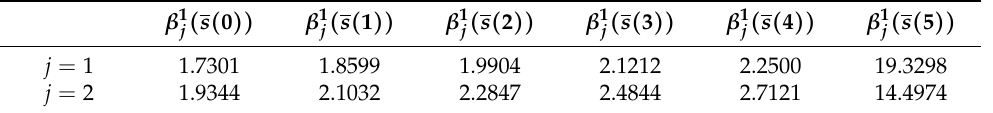
Table 7. Payoff distribution procedure (PDP) in the first (economic)